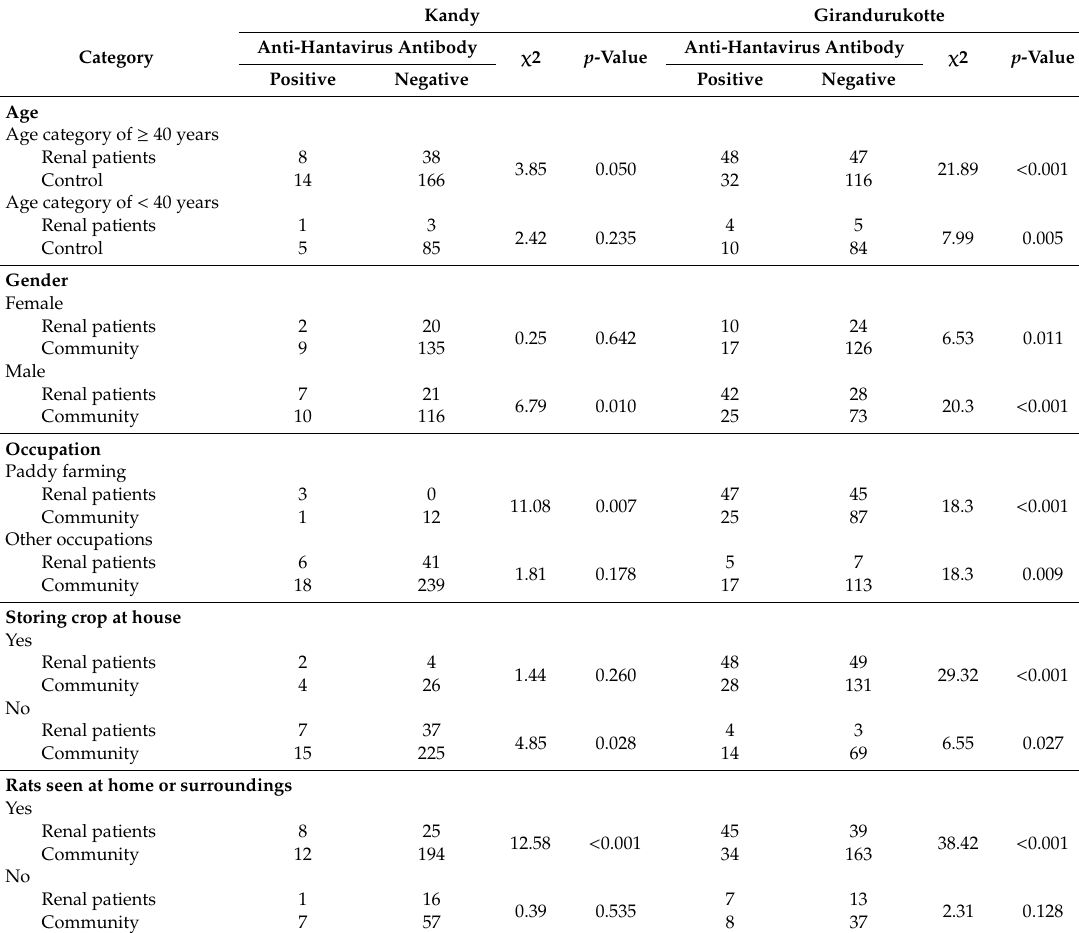
Table 2. Comparison of possible risk factors for exposure to hantavirus in Kandy and Girandurukotte.